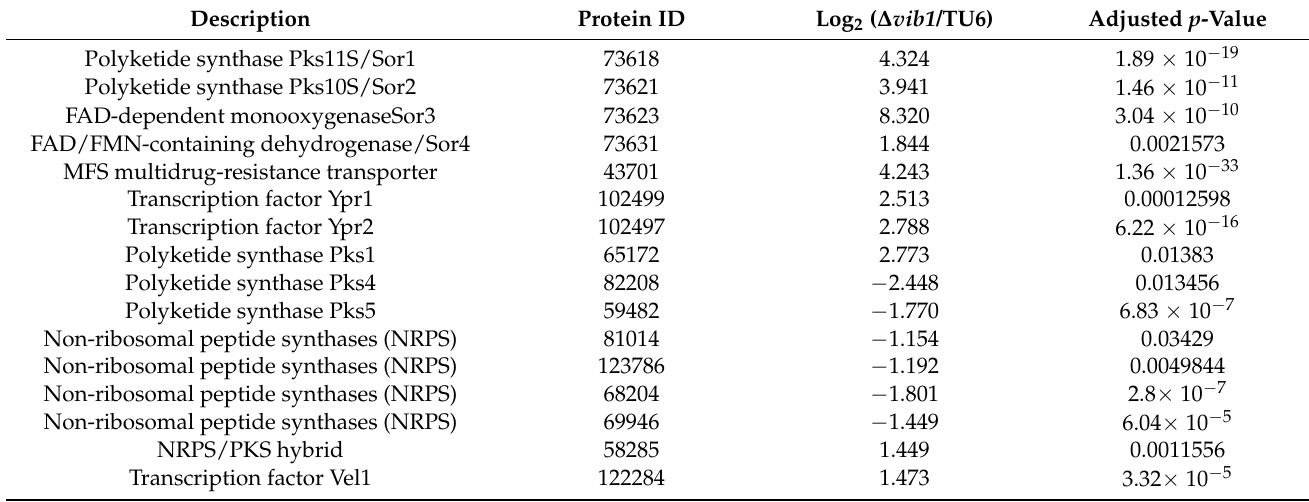
Table 1. Vib1 affects the expression of the SOR cluster and other secondary metabolism-associated genes on